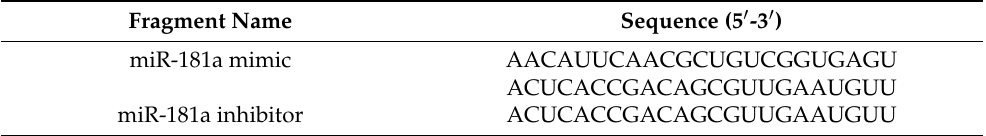
Table 3. Sequences of oligonucleotide.